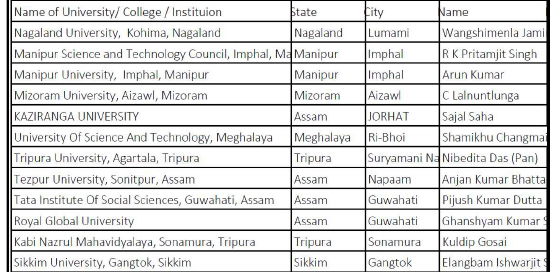
Figure 8. A Screenshot of the List of Academic Institutions and Centre Coordina tors for the online examination